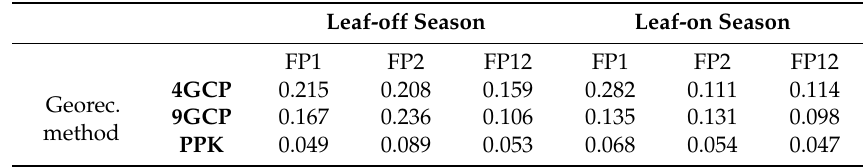
Table 3. Horizontal root mean square errors (RMSE xy ) of validation points used in Photoscan software (in